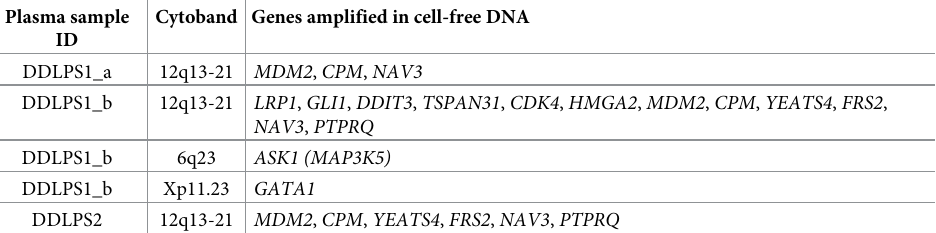
Table 3. Copy number alterations identified in cell-free DNA of patients DDLPS1 and DDLPS2 that affect genes known to be recurrently amplified in